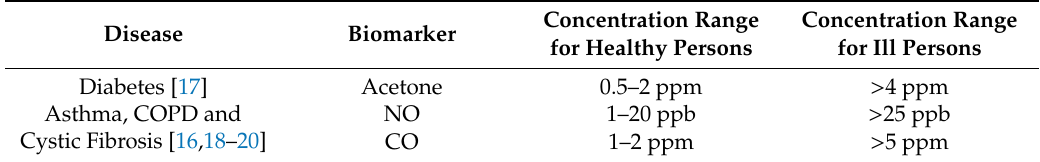
Table 1. Concentration ranges are used for the di ff erent biomarkers, both for healthy people and for patients with di ff erent